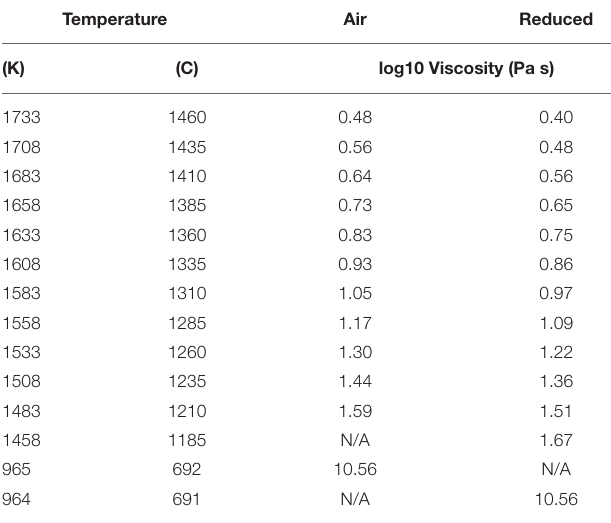
Temperature Air